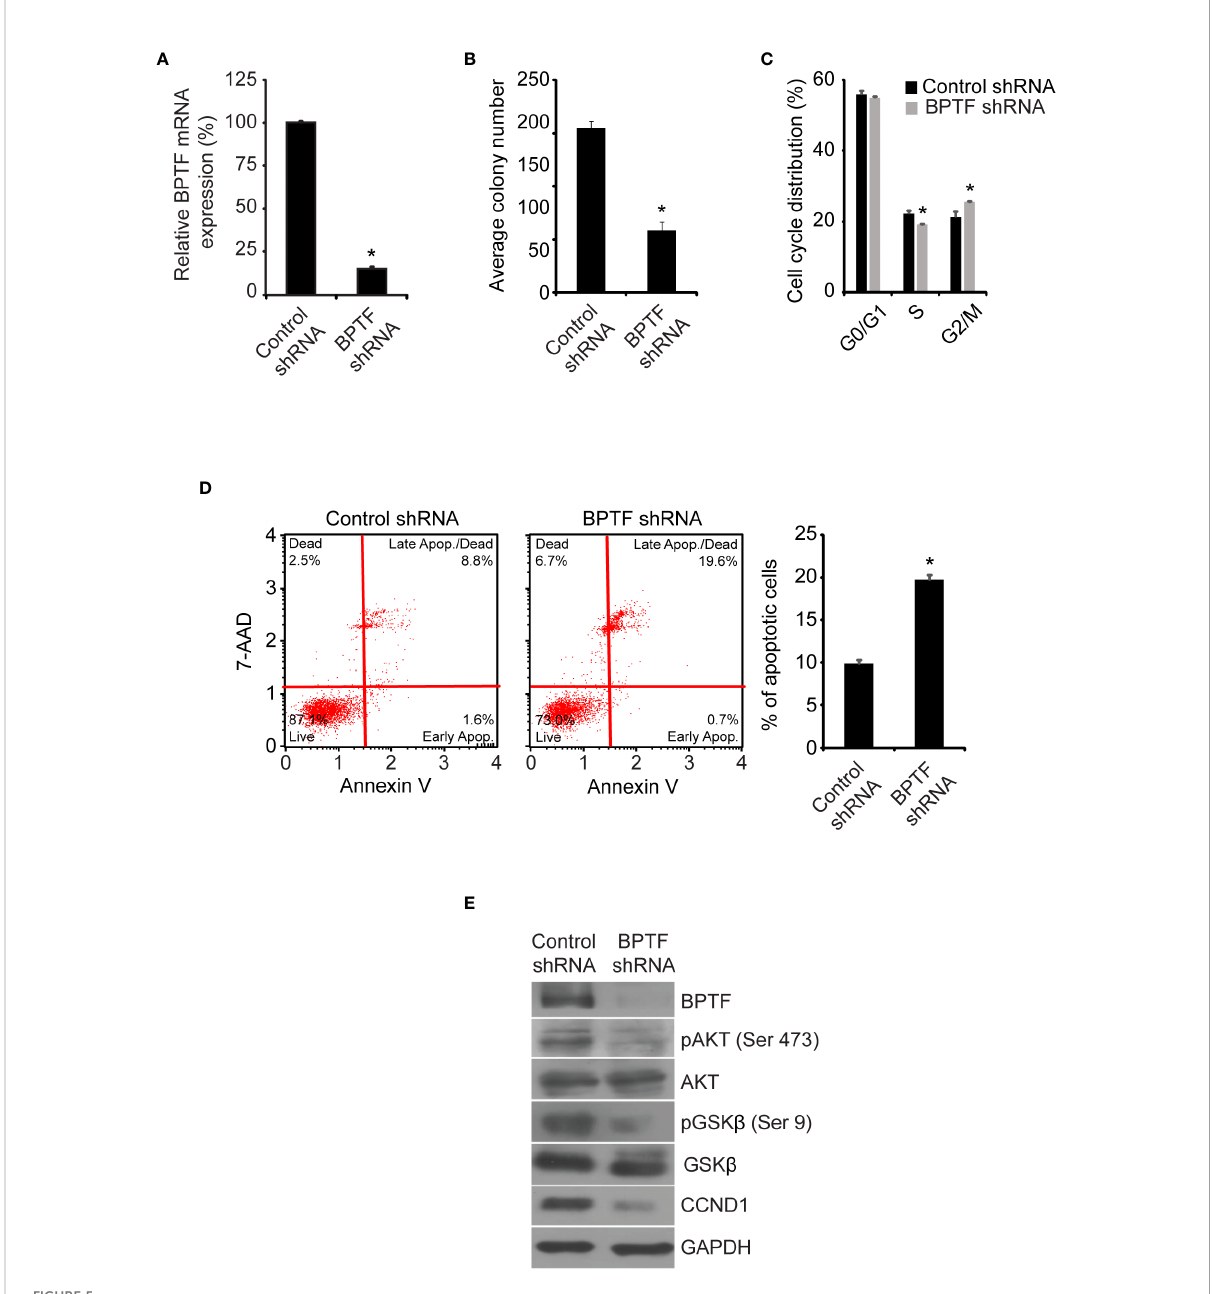
FIGURE 5 Effects of shRNA-mediated suppression of BPTF on MCF-7 cells. (A) BPTF mRNA expression following shRNA-mediated knockdown. (B) Colony formation ability of MCF-7 cells following BPTF silencing. (C) Cell cycle analysis following BPTF suppression. (D) Analysis of apoptotic rate after BPTF silencing based on detection of 7-AAD and Annexin V. (E) Western analysis of expression of different proteins following BPTF silencing in MCF-7 cells. *p <